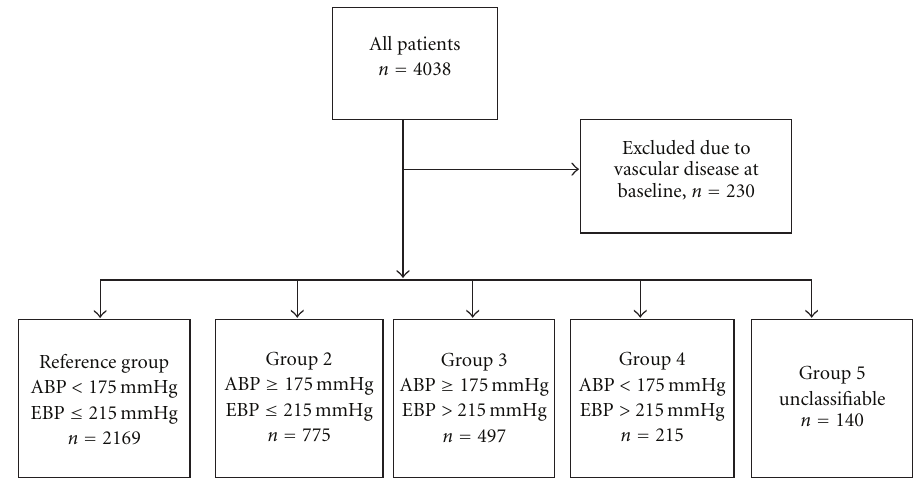
Figure 1: A flow-chart describing derivation of the blood pressure groups from all consecutive patients undergoing a clinical exercise test during the period 1989 to 1995. ABP: ankle blood pressure, EBP: brachial exercise blood pressure at the level of 150 Watts for men and 80 Watts for women.